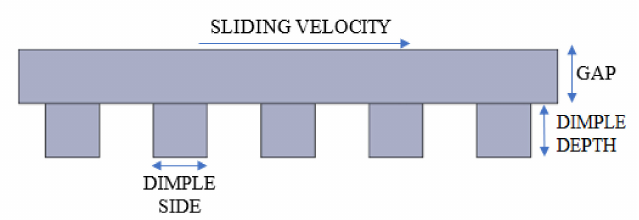
Figure 10. Graphic representation of the full texturing configuration with the main geometric features